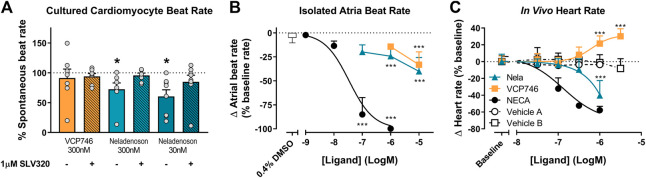

Ex vivo and in vivo A1R-mediated chronotropic effects. In isolated neonatal ventricular cardiomyocytes, VCP746 (n = 7) had no effect on the spontaneous contraction rate of cells (A), while neladenoson (30 nM: n = 7; 300 nM: n = 8) showed a significant depressive effect, which is completely abrogated by pre-treatment with the A1R antagonist SLV320 (statistics were performed on raw data; paired Student’s t-test, comparison of VCP746/neladenoson-treated cells to the same cells prior to treatment; *(p < 0.05)). Data are mean ± SEM. In isolated atria (B), NECA produced a concentration-dependent effect (n = 8), while only minor effects of VCP746/neladenoson (n = 4–9) were observed at high concentrations (1 or 10 μM; one-way ANOVA compared with vehicle alone; ***(p < 0.01)). (C) Adenosinergic compounds were also tested in vivo. NECA (n = 6) decreased heart rate relative to vehicle A (n = 2). Neladenoson (n = 4) significantly reduced heart rate at 1µM relative to vehicle B (n = 7), while VCP746 (n = 5) increased heart rate at high concentrations in vivo (two-way ANOVA, Sidak’s multiple comparisons, compared with vehicle B). Data for (B) and (C) are expressed as mean ± SD.